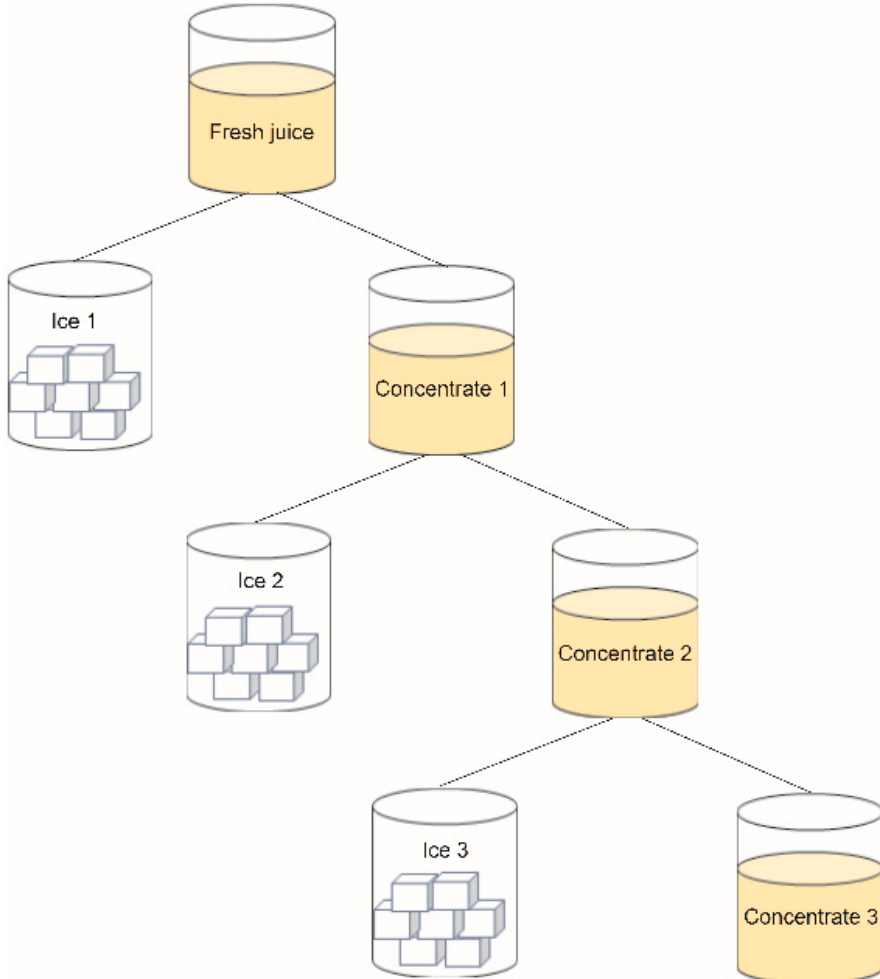
Figure 1. Freeze crystallization procedure at three centrifugation cycles.